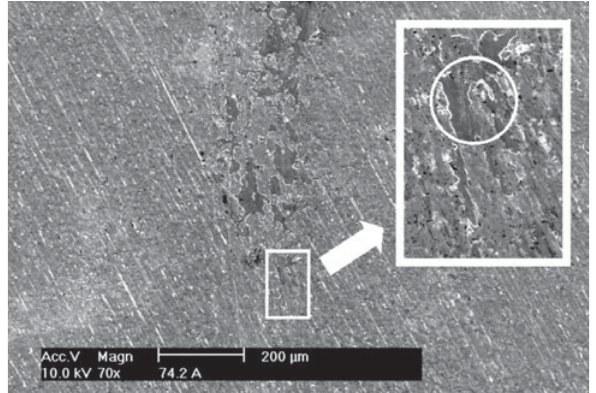
Figure 5. SEM photomicrographs under 70× magnification after POD test in a nitrided sample. The circle in the inset shows where EDS was performed.